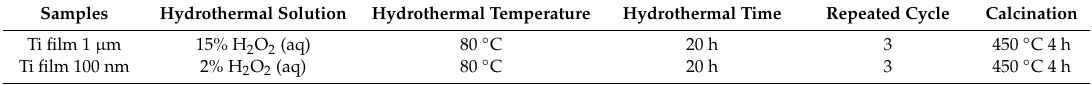
Table 1. Hydrothermal treatment process for each